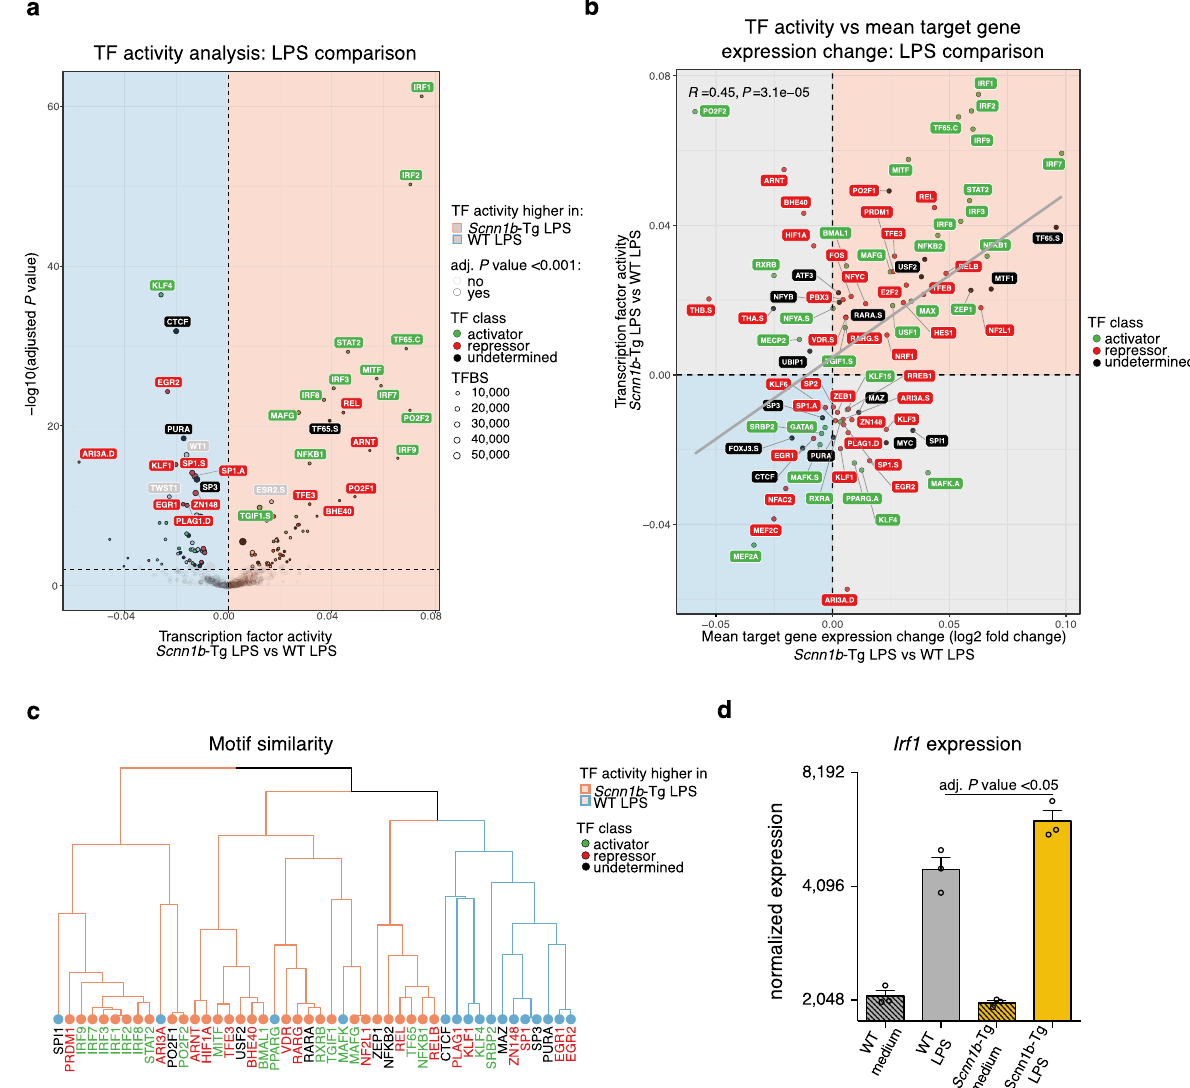
Fig. 5 Differential transcription factor activity orchestrates LPS responses in Scnn1b -Tg AMs. a Differential transcription factor (TF) activity analysis of lipopolysaccharide (LPS) treated Scnn1b -transgenic (Tg) vs. wild-type (WT) airway macrophages (AM). A positive weighted mean difference indicates increased TF activity in Scnn1b -Tg AMs. Size indicates the number of TF binding sites (TFBS). Green labeled TFs are predicted activators, red labeled TFs are predicted repressors, and black labeled TFs have no direction assigned. b Pearson correlation of TF activity of signi fi cantly enriched TFs (adjusted (adj.) P value < 0.001) in Scnn1b -Tg vs. WT AM treated with LPS on the y -axis, with mean target gene expression change on the x -axis. The gray diagonal represents the linear regression. c Clustering of differentially activated TFs (adj. P value <10e − 6) based on the similarity of their position weight matrixes. Coloring of tree leaves based on TF activity. Coloring of labels de fi ned by TF class. d Normalized Irf1 gene counts obtained by RNA sequencing (RNAseq) ( Scnn1b- Tg LPS vs. WT LPS) in treated and untreated Scnn1b -Tg and WT AMs. Adj. P values were determined by DESeq2. The data show mean ± SEM of n = 3. Source data are provided as a Source Data fi